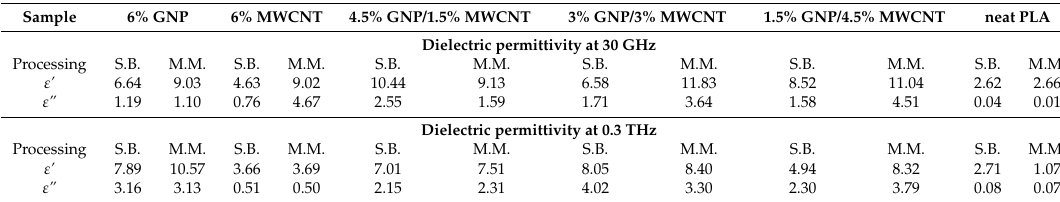
Table 3. Constitutive parameters of composites in microwave and THz range.